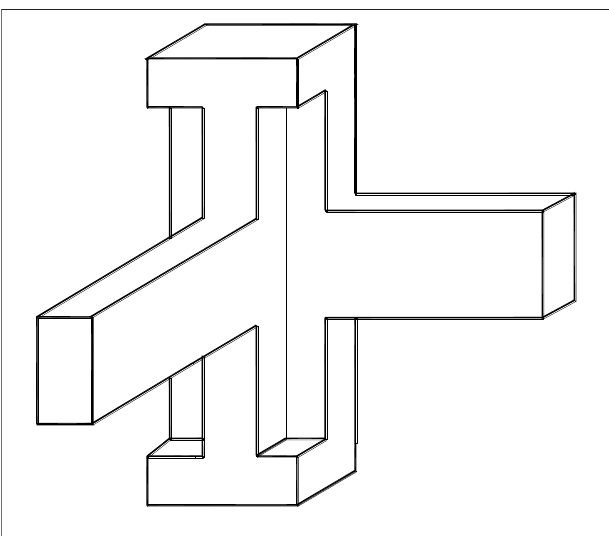
FIGURE 1 | Stereogram of